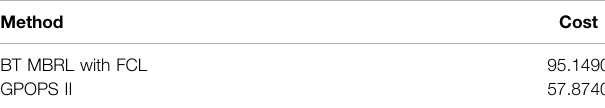
TABLE 3 | Costs for a single barrier transformed trajectory of (37) , obtained using the developed method, and using pseudospectral numerical optimal control software.